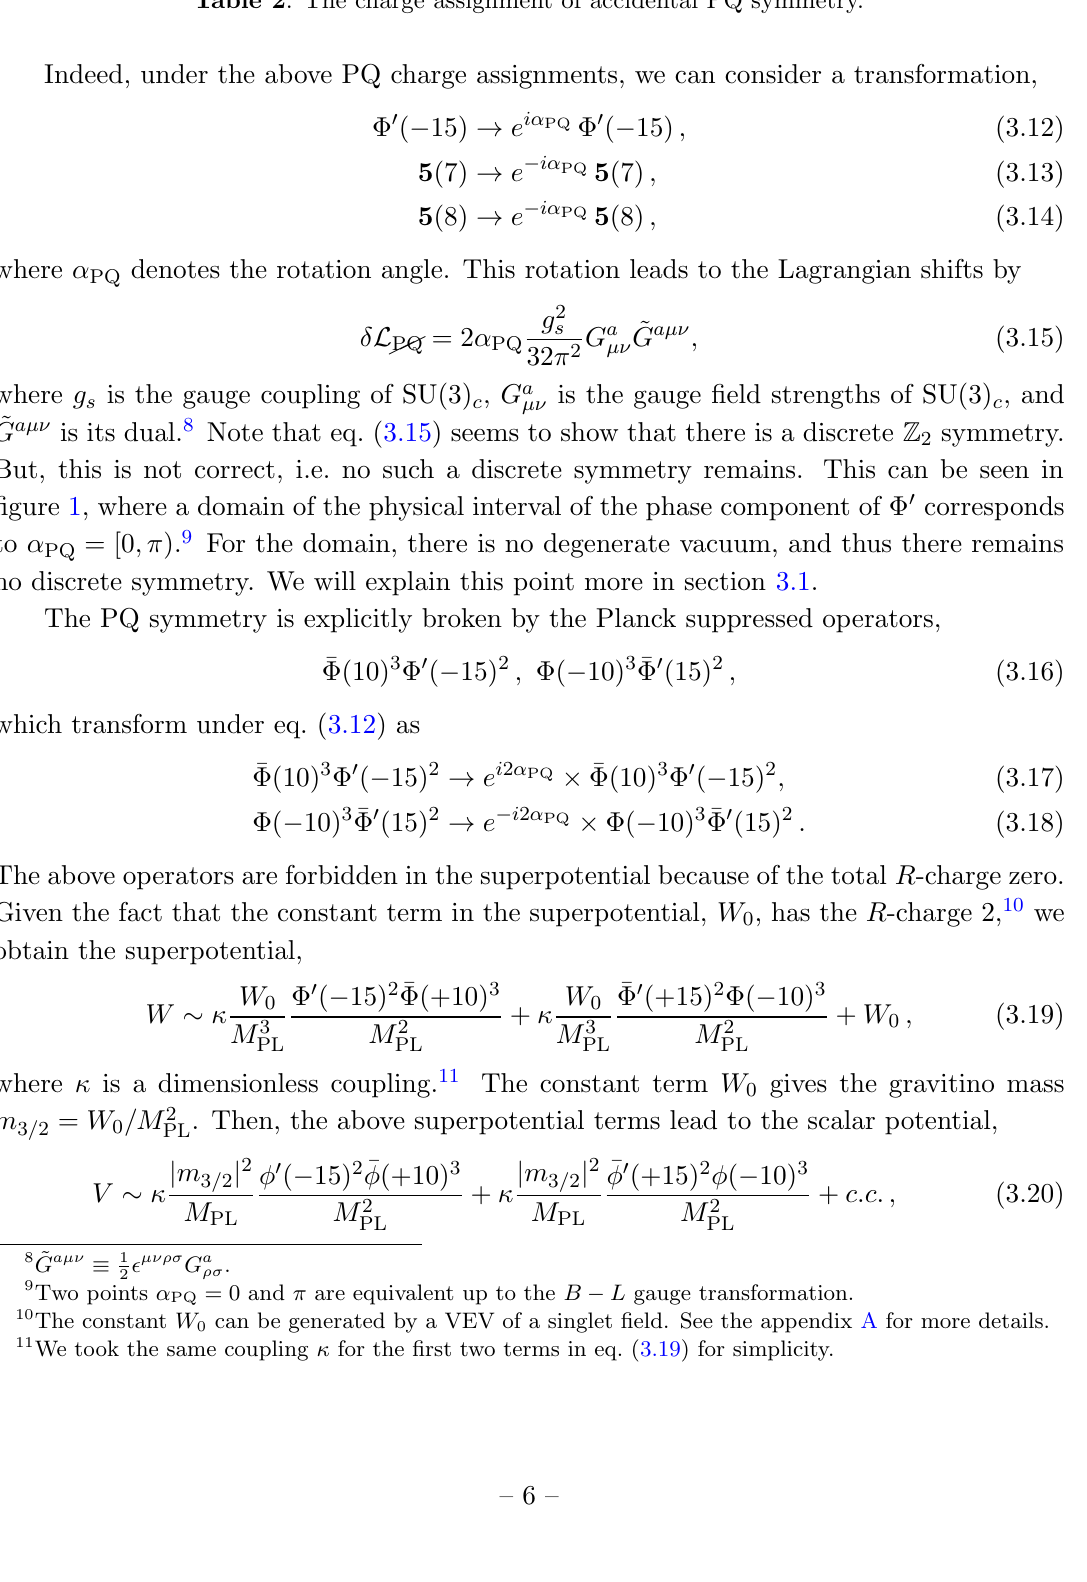
Table 2 . The charge assignment of accidental PQ